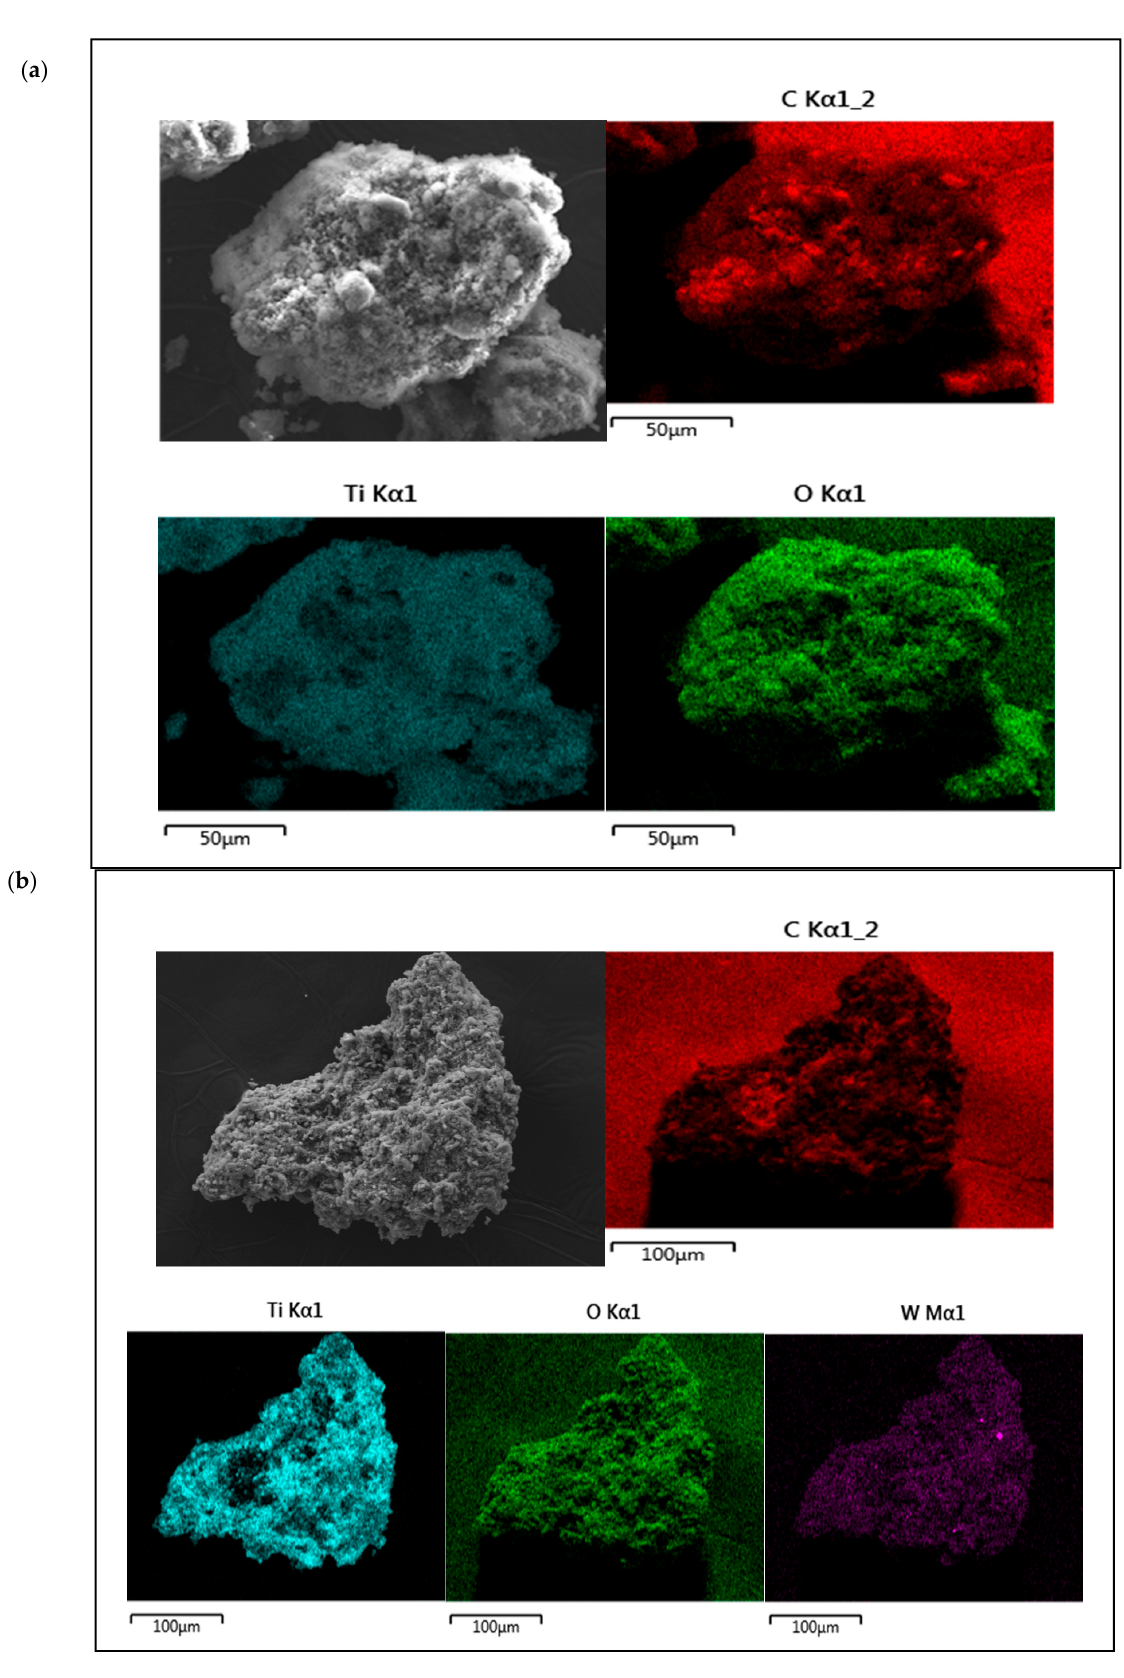
Figure 1. Field emission scanning electron microscopy and EDS images for ( a ) HCP25 (5000 × ) and ( b ) HCP25W (5000 × ). The first microscopic image is in the same scale with the EDS